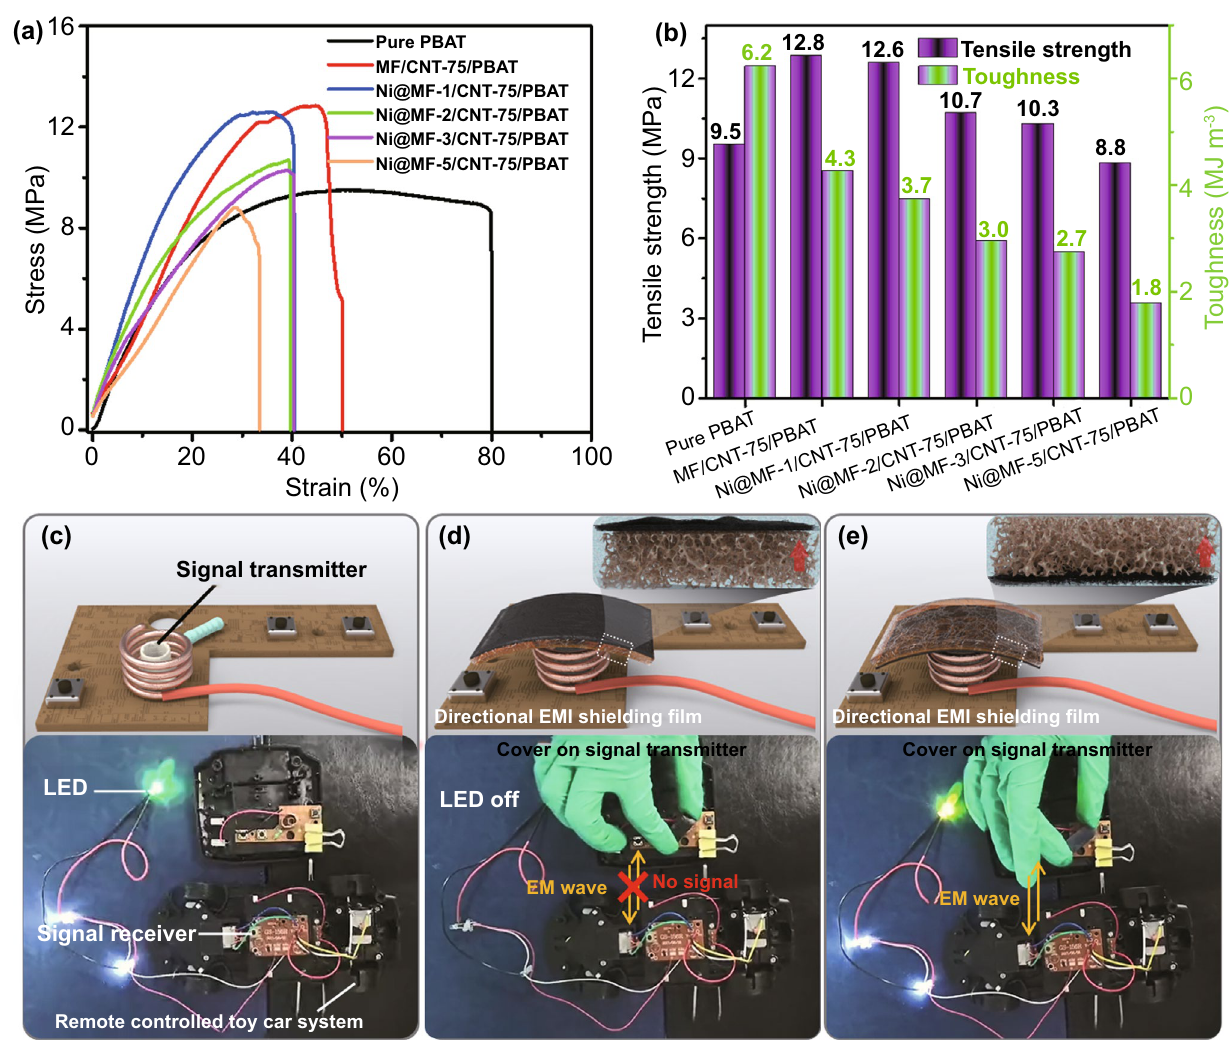
Fig. 5 Practical application for directional EMI shielding. a Typical stress–strain curves of pure PBAT and step-wise asymmetric Ni@MF/ CNT-75/PBAT composites with different Ni-plating times. b The corresponding tensile strength and toughness. C–e A real directional EMI shielding application measurement in a remote controlled toy car system. The signal transmitter is faced with c no shielding material, d Ni@MF layer, and e CNT-75 layer of the Ni@MF-5/CNT-75/PBAT